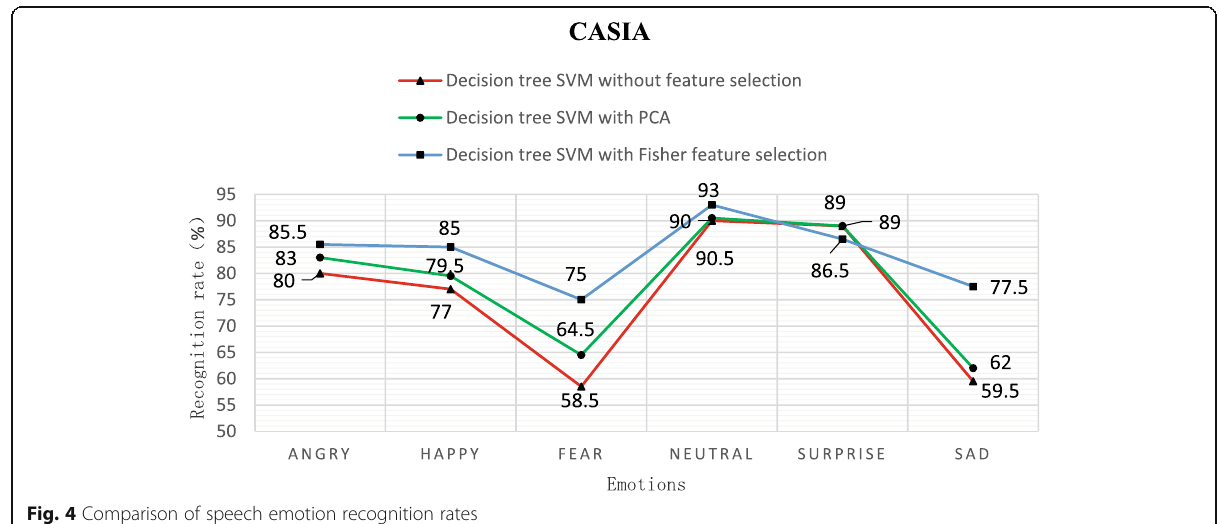
Fig. 4 Comparison of speech emotion recognition rates